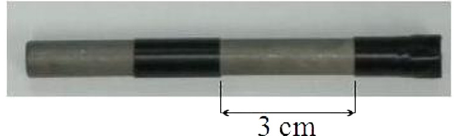
Figure 1: Sample of HSHCsw with black - colour adhesive tapes on both